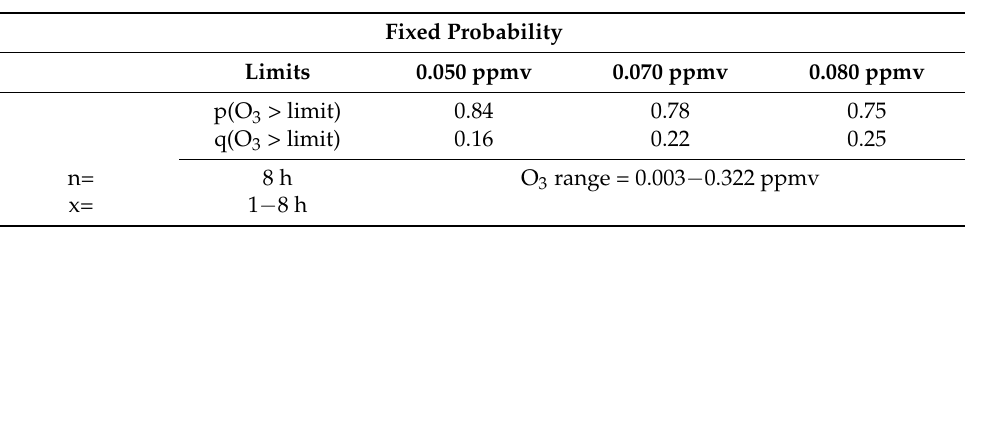
Table 3. Binomial function’s